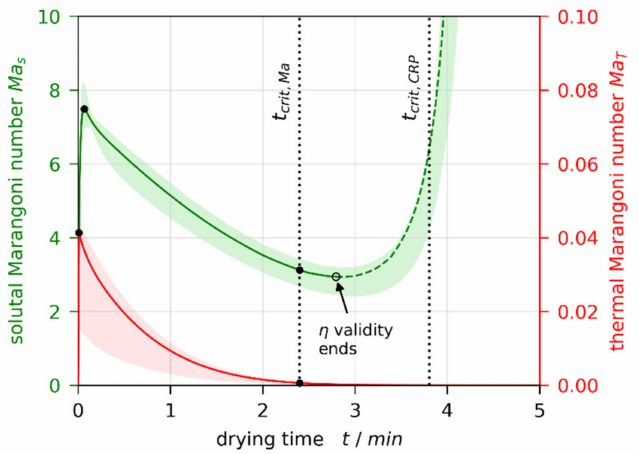
Figure 10. Transient thermal and solutal Marangoni numbers calculated from a non-isothermal simu- lation matched to a µ PTV experiment ( X 0 = 1.5 g Ma s is two orders of magnitude larger than Ma T . The colored areas indicate the uncertainty due to α bottom variation, as well as choice of reference concentration and temperature for η , a , and D calculation. The black filled circles indicate extracted data for further discussion. The dashed portion of Ma s is deemed invalid, since viscosity data are extrapolated and the film starts to